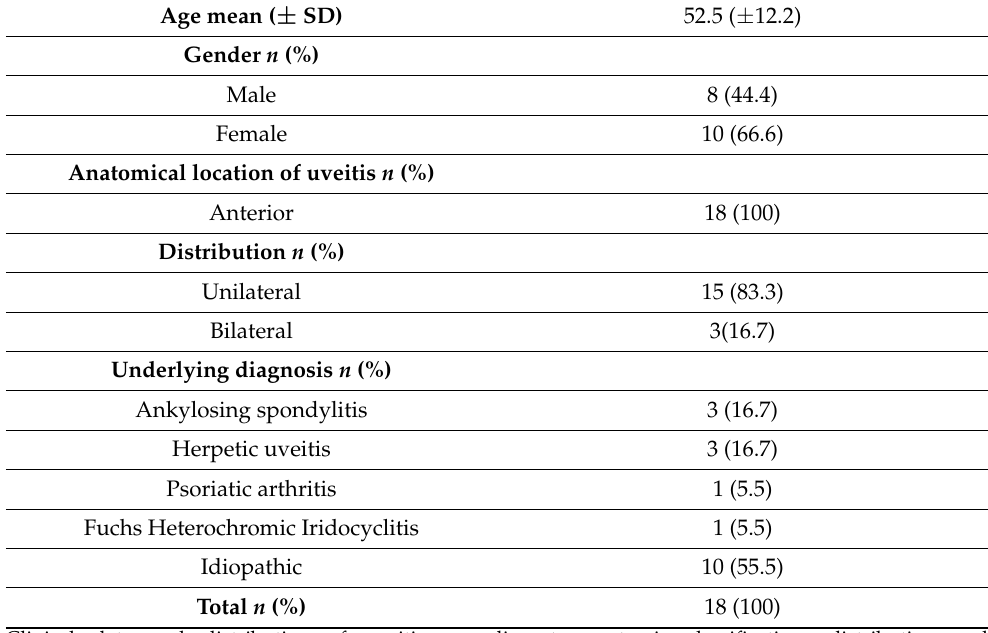
Table 1. Clinical data of uveitis